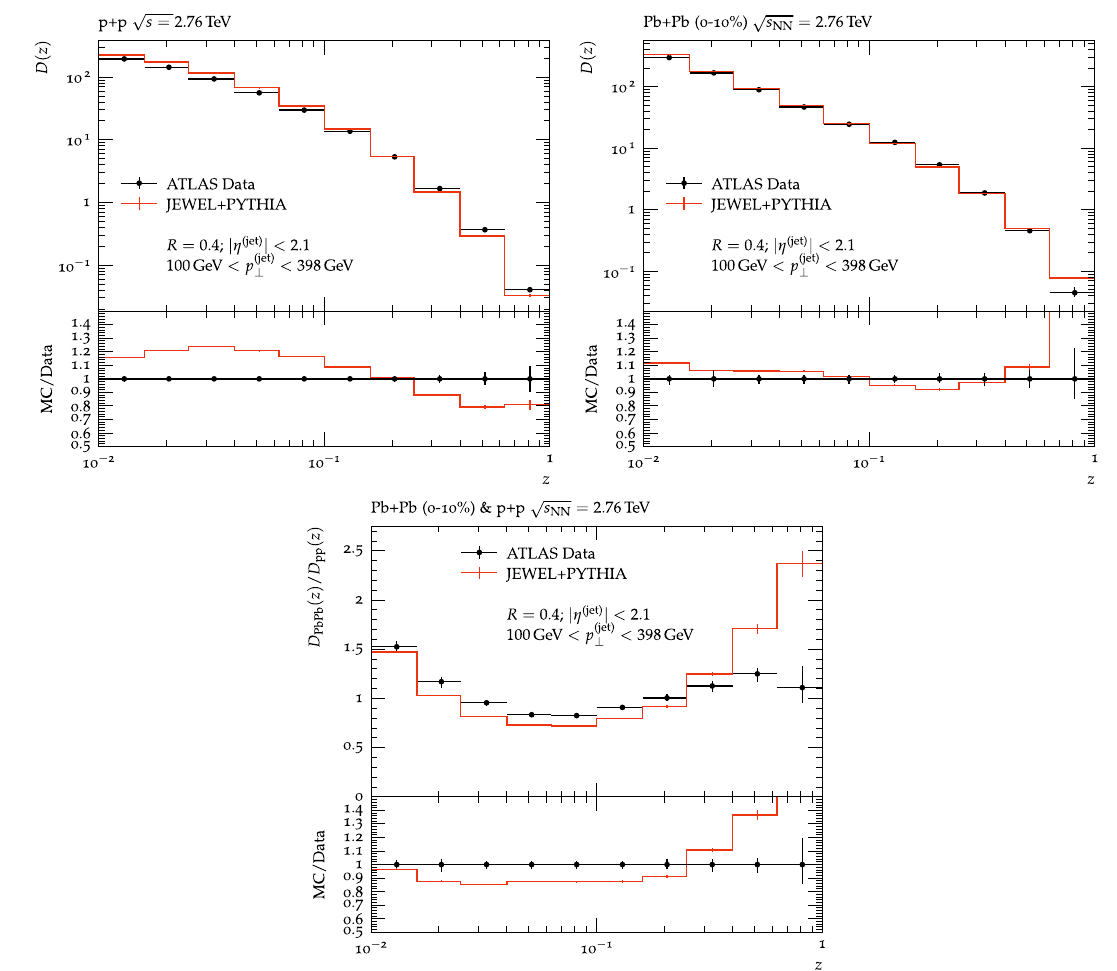
( jet ) < 398 GeV and | η ( jet ) | < 2 . 1 in p+p jets with 100 GeV < p ⊥ and Pb+Pb (0 − 10% centrality) collisions. JEWEL+PYTHIA results are shown with constituent subtraction for charged particles with the same p ⊥ cut as in the